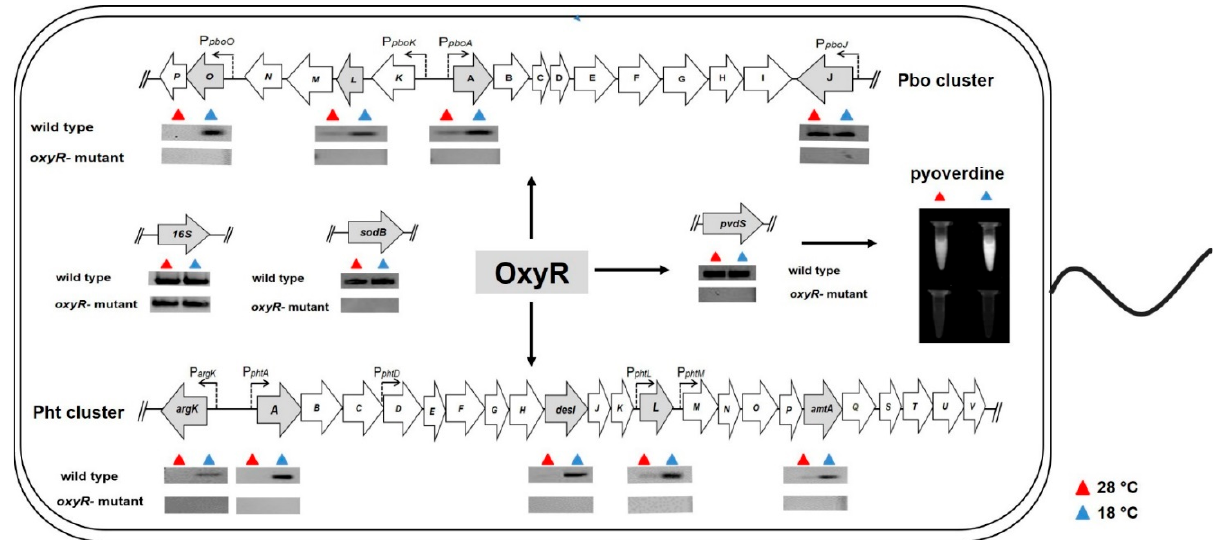
Figure 3. Expression analysis by RT-PCR assays and pyoverdine production. The figure depicts the effects that the OxyR protein exerts on the expression of the studied genes and on the pyoverdine synthesis. In the figure is included a graphic representation of the Pht and Pbo clusters and sodB, pvdS genes. The housekeeping 16S rDNA gene (16S) was also evaluated and used as an internal control. Each arrow represents an individual gene, with the direction of the arrow indicating the direction of transcription. Gray arrows indicate the genes evaluated by RT-PCR analyses, which are shown under each gene evaluated by a band amplified (black) or absent in wild type and oxyR-mutant al 28 °C (indicated by red triangle) and 18 °C (indicated by blue triangle). Twenty-eight amplification cycles were used in most of the RT-PCR assays. The 16SrRNA was evaluated using 23 cycles of amplification. Representative image showing the production of fluorescent siderophore pyoverdine assessed under UV light is also included.